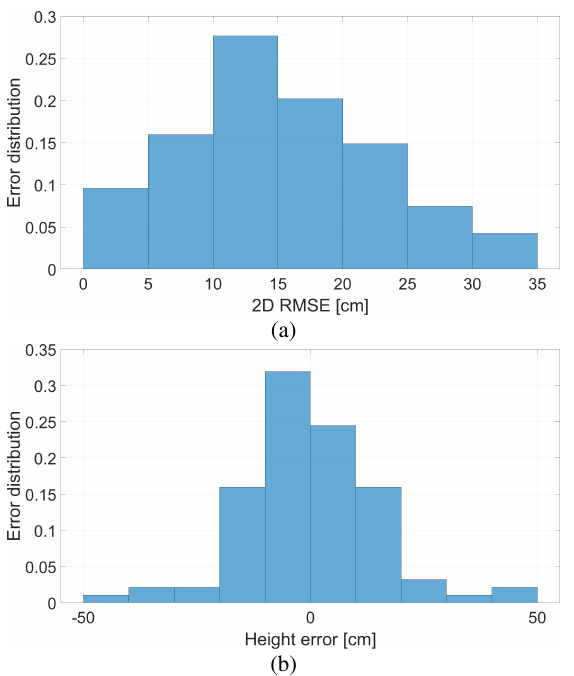
Figure 7. Points (in red) with largest position differences between point clouds generated with photogrammetry and ToF camera.